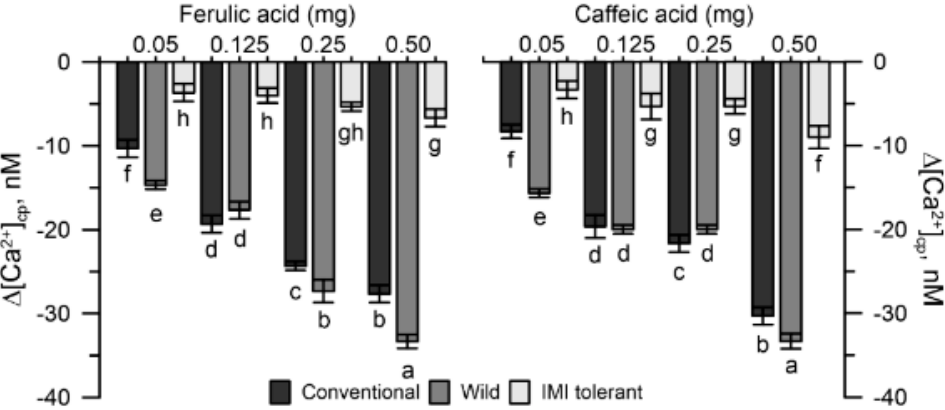
Figure 5. Effects of ferulic acid and caffeic acid on the cytosolic Ca 2+ of conventional, wild and IMI-tolerant sunflower pollen. Data are expressed as means ± SEM from 4 independent tests. Statistically significant differences are indicated by different letters, whereas identical letters highlight non-significant trends. SEM, standard error of the mean.